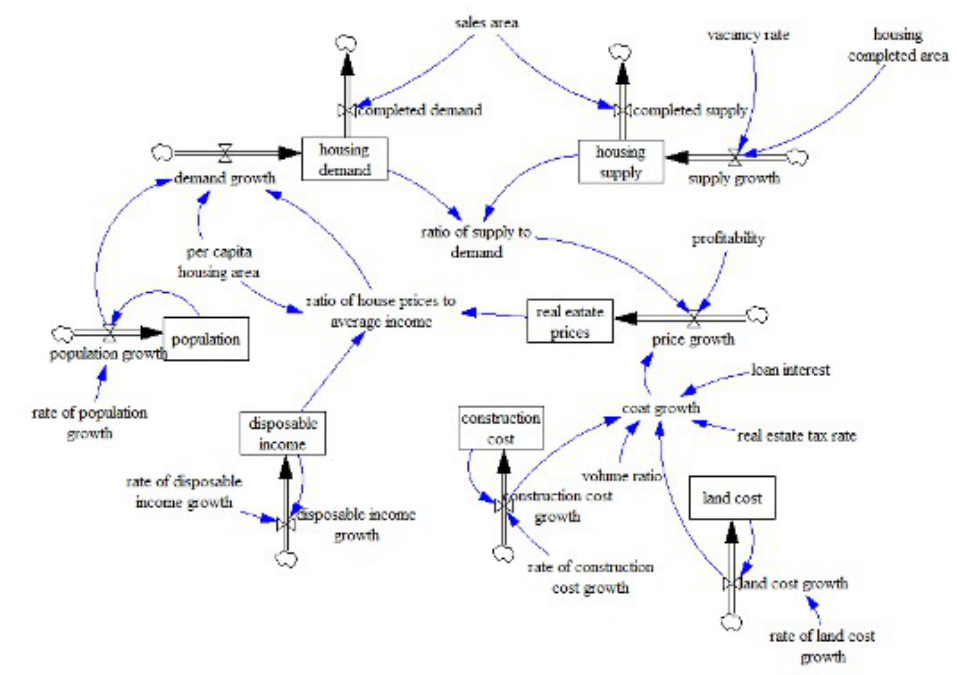
Figure 3. System flow diagram of the impact on the real estate